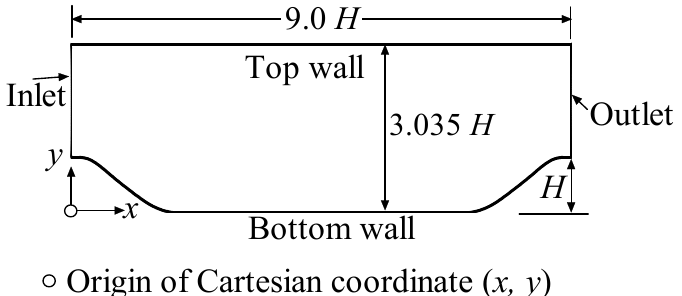
Figure 10. Computational model of the 2D periodic hill flow.